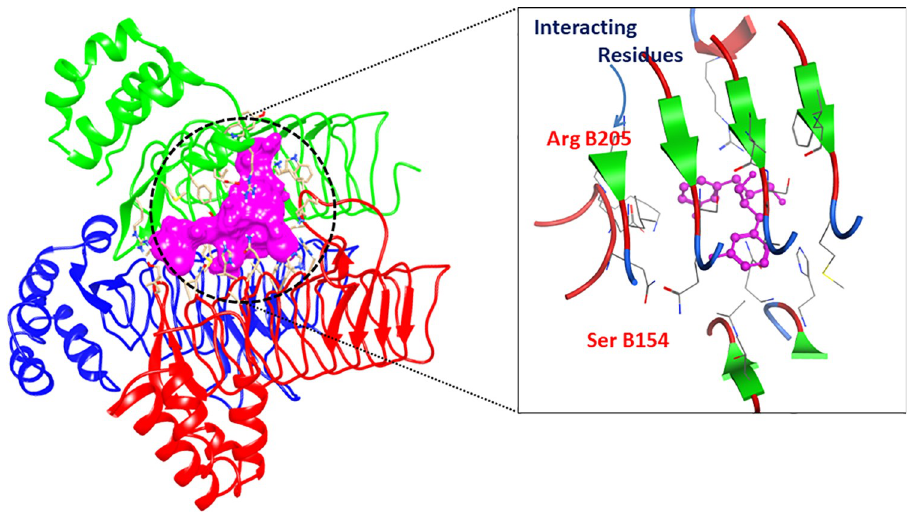
Fig 5. 2D and 3D interaction diagram of Acyl-[acyl-carrier-protein]—UDP-N acetyl glucosamine O- acyltransferase protein. The structure shows complex with